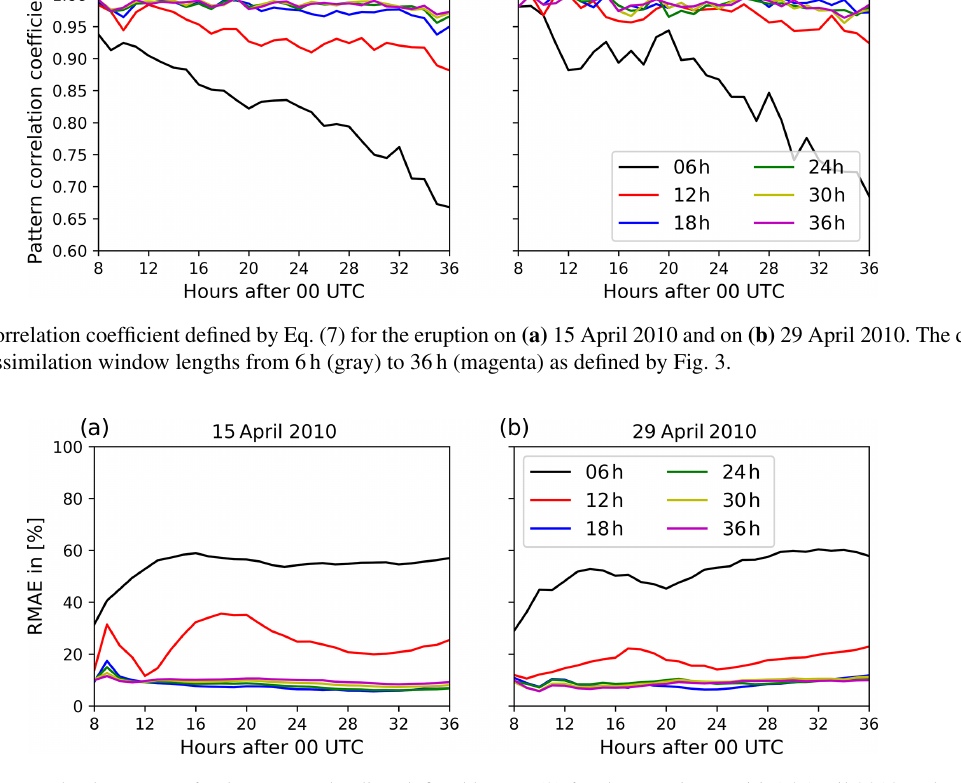
Figure 7. Relative mean absolute error of column mass loading defined by Eq. (9) for the eruption on (a) 15 April 2010 and on (b) 29 April 2010. The different lines indicate different assimilation window lengths from 6h (gray) to 36h (magenta) as defined by Fig.